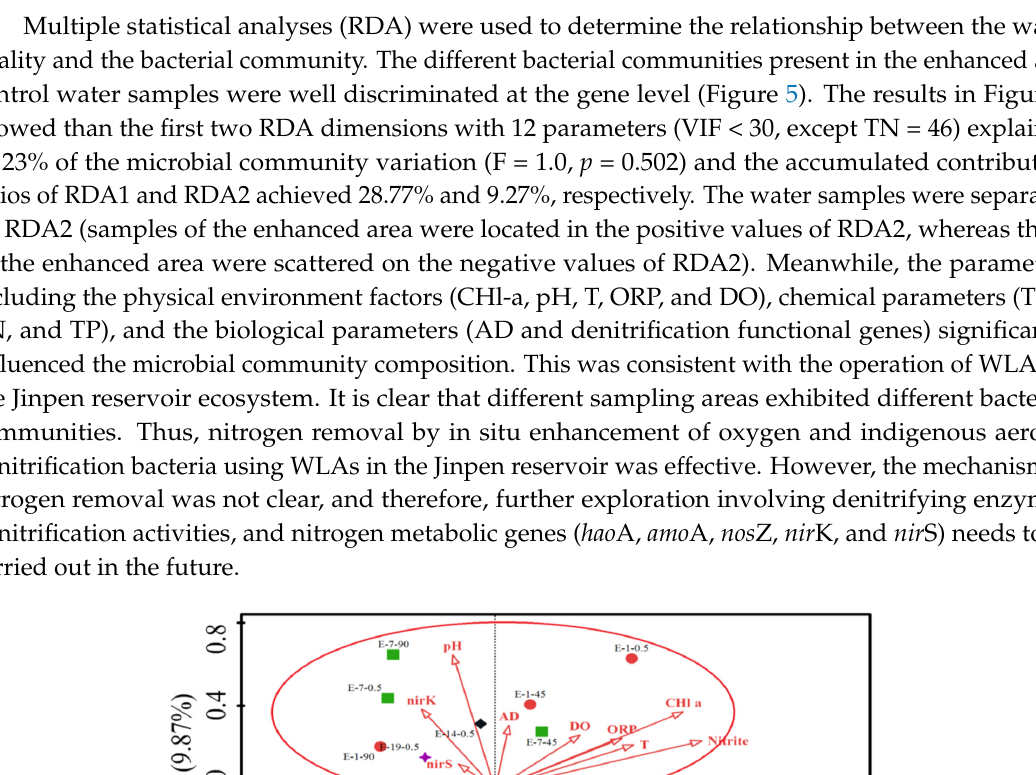
Figure 7. Principal component analysis (PCA) of water samples in the enhanced and control areas.